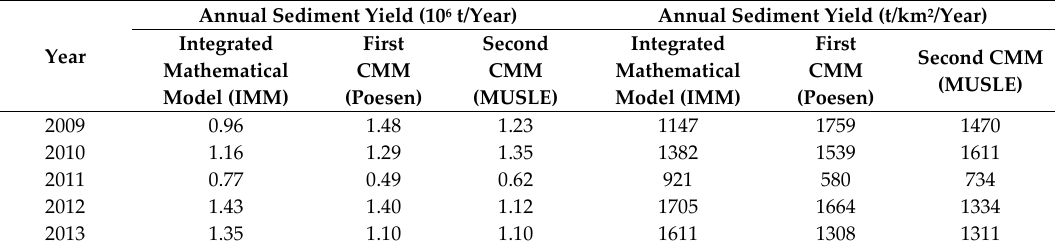
Table 2. Annual sediment yields at the basin